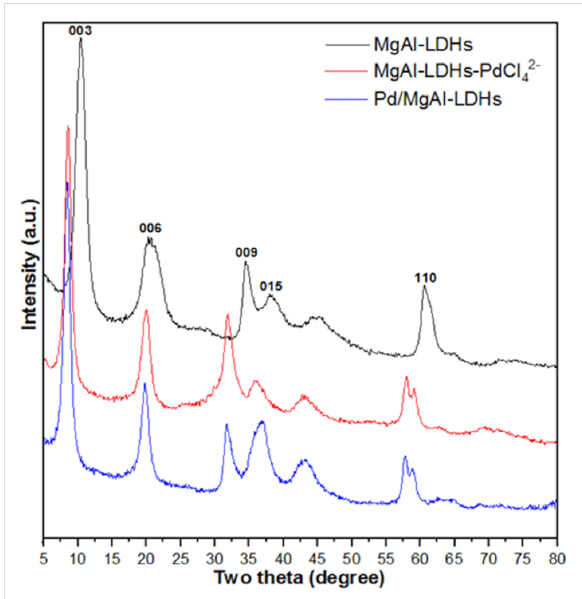
Figure 1: The XRD patterns for the samples of MgAl-LDHs, MgAl- LDHs-PdCl 42 − and